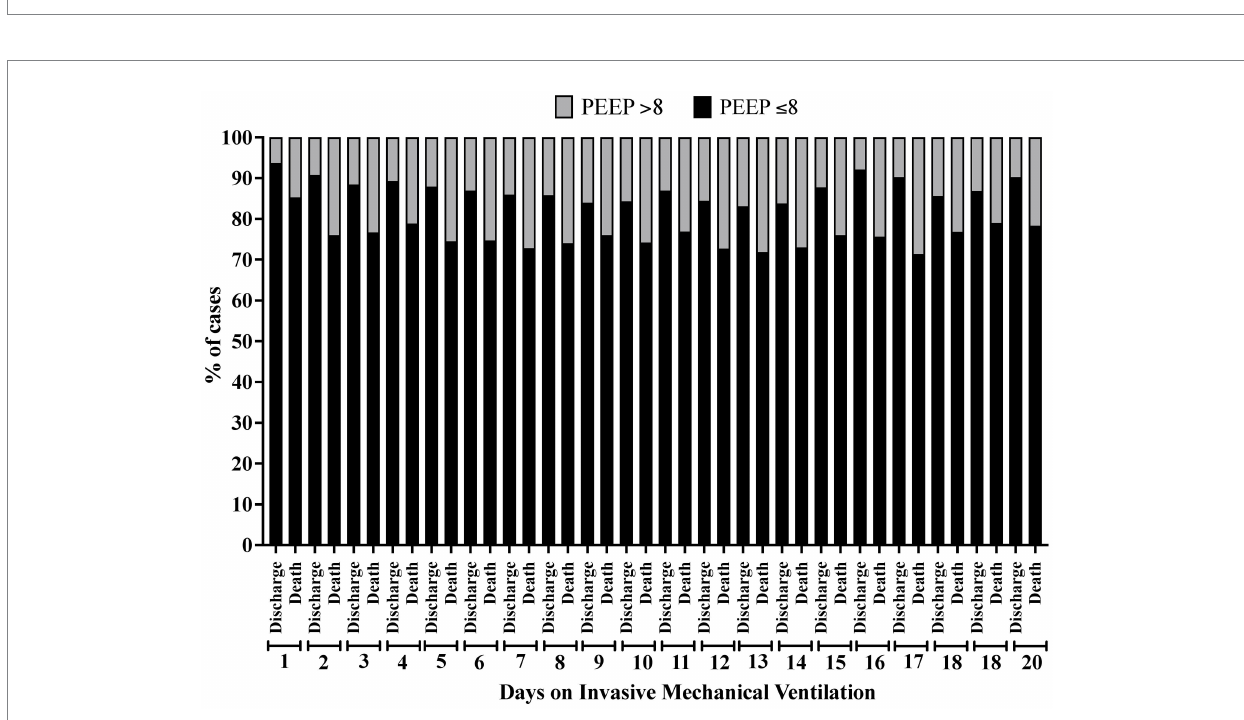
FIGURE 6 Percentage of patients according to the clinical outcome distributed by the positive end-expiratory pressure (PEEP) value ( ≤ 8 cmH 2 O or > 8 cmH 2 O) and according to the time of invasive mechanical ventilation (days 1 to